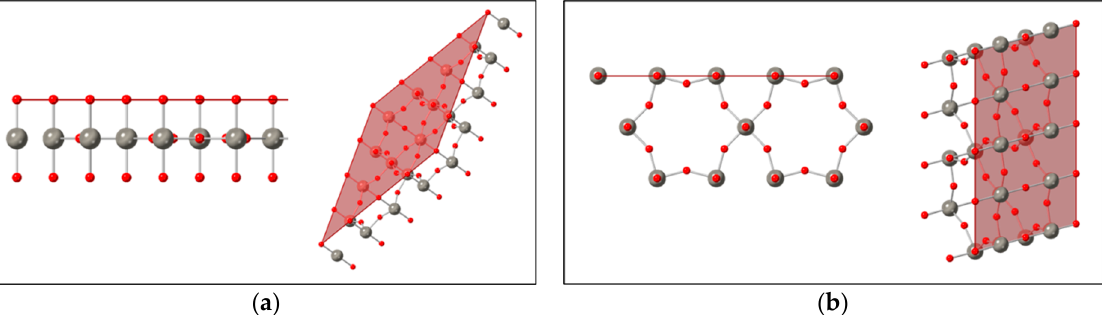
Figure 6. Geometrical structures of the (001) terminated surface ( a ) and the (100) terminated surface ( b ) from h- WO3. The crystal structure is ICSD 32001 from Gerand et al. Ref [3]. Red spheres indicate oxygen atoms, while green spheres indicate tungsten atoms. The viewing directions for the structures from left to right are [010], [111], [001], and [101].